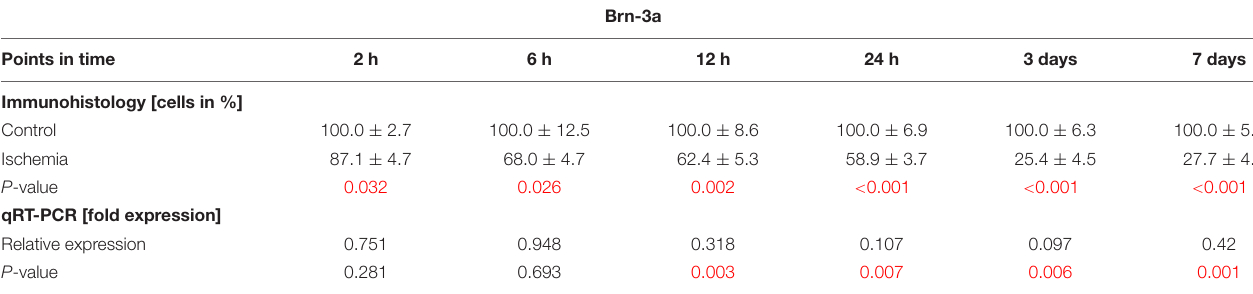
FIGURE 3 | (A) Brn-3a (green) was used to stain RGCs on retinae of all points in time ( n = 7–8/group). Cell nuclei were labeled with DAPI (blue). Fewer Brn-3a + cells were observed in the ischemia group over time. (B) A significant RGC loss was noted 2 h after I/R ( p = 0.032), which remained until day 7 and became increasingly stronger over the time (6 h: p = 0.026; 12 h: p = 0.002; 24 h, 3 days, 7 days: p < 0.001). (C) Via qRT-PCR, a significant down-regulation of Pou4f1 mRNA levels was verified starting 12 h after ischemia (12 h: p = 0.003; 24 h: p = 0.007; 3 days: p = 0.006; 7 days: p = 0.001). ∗ p < 0.05, ∗∗ p < 0.01, ∗∗∗ p < 0.001. GCL, ganglion cell layer; IPL, inner plexiform layer; INL, inner nuclear layer. Scale bar: 20 µ m. TABLE 5 | Analyses of the Brn-3a staining (%), control groups were all set at